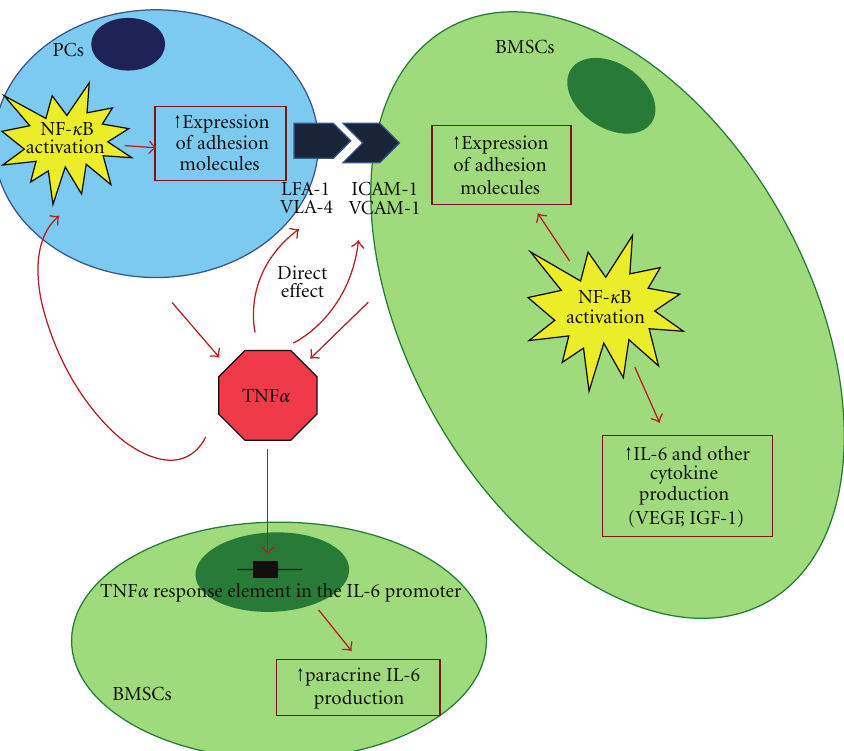
Figure 4: Induction of IL-6 secretion by TNF α and NF-kB